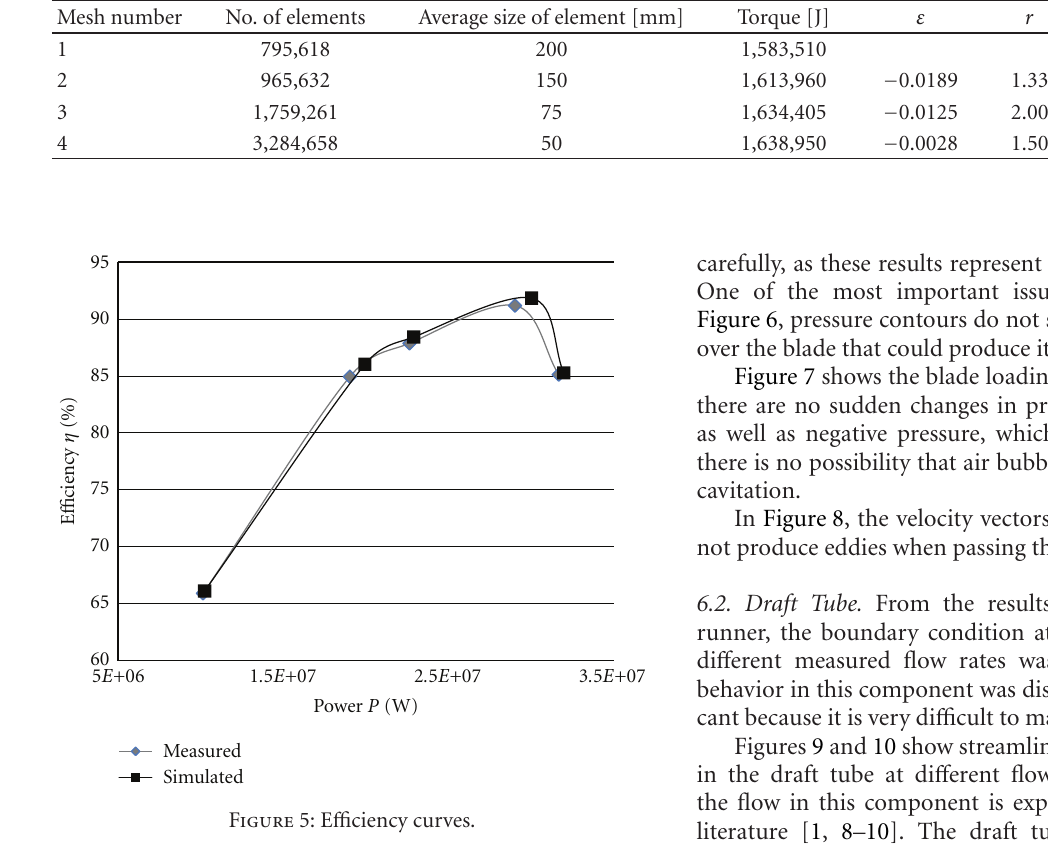
Table 2: Analysis GCI.